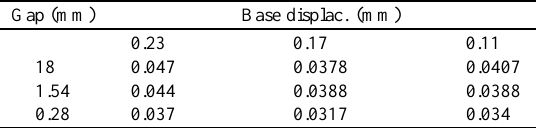
Fig. 7. Effect of magnet arrangement on performance of MCLD: (a) Magnets in attraction and (b) Magnets in repulsion. Table 1 Effect of gap and base displacement on damping ratio (magnets in